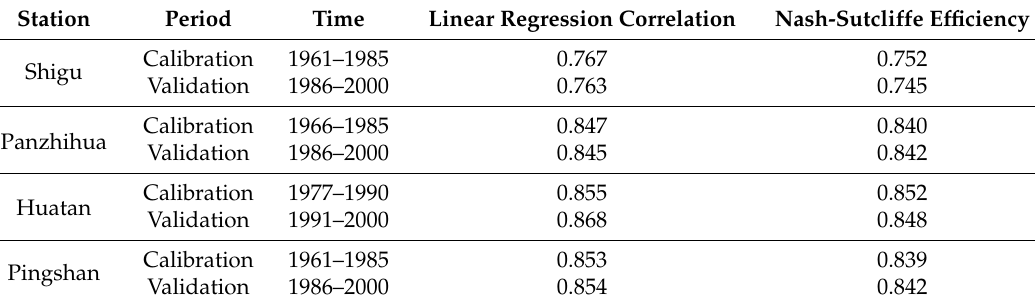
Figure 8. Simulated and observed daily streamflow of Pingshan station: ( a ) calibration, and ( b ) validation. Table 6. Performance of XAJ model.